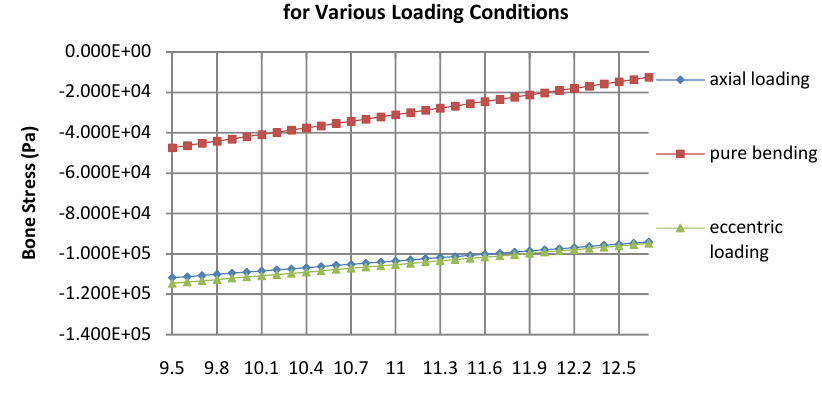
Fig. 3 Theoretical prediction of stress in